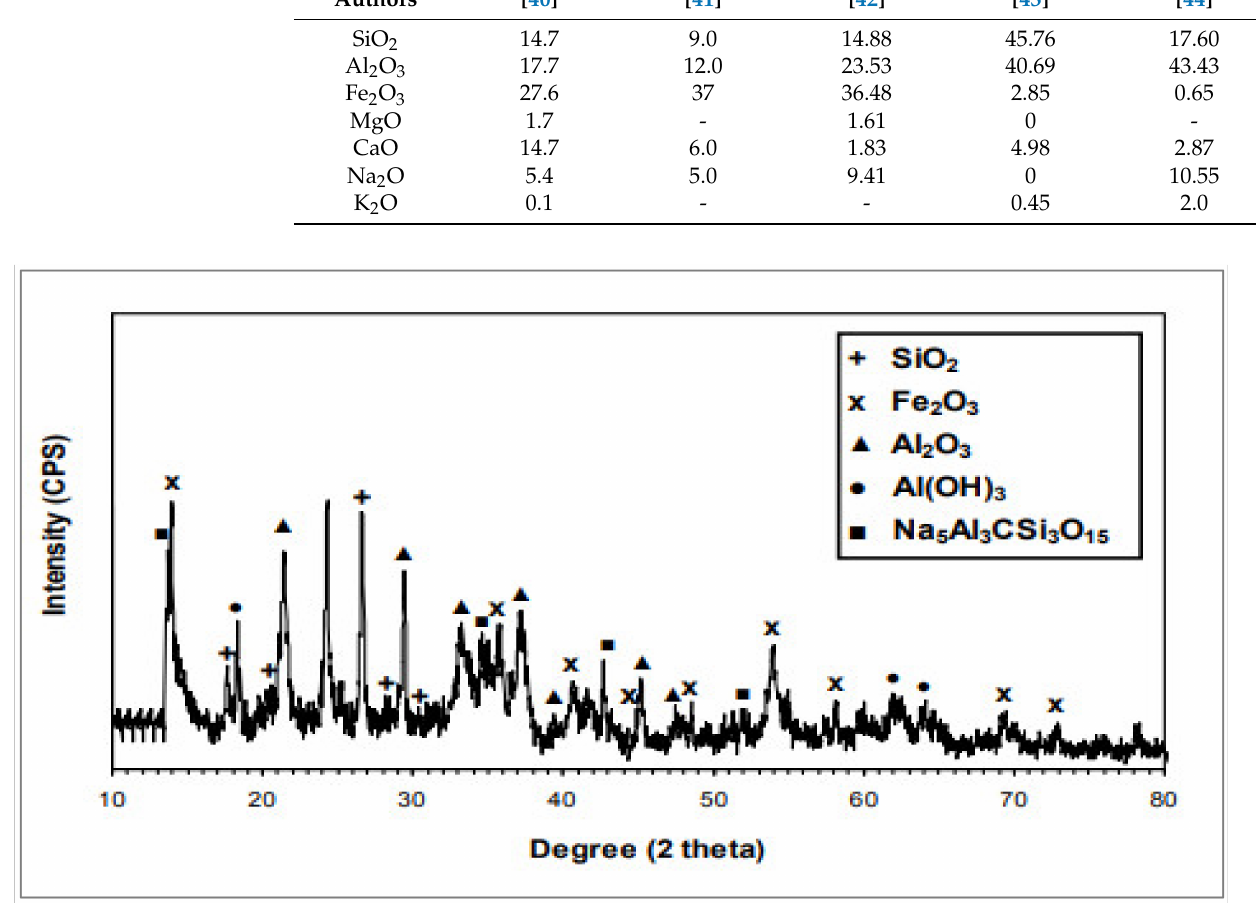
Figure 5. XRD of RDM